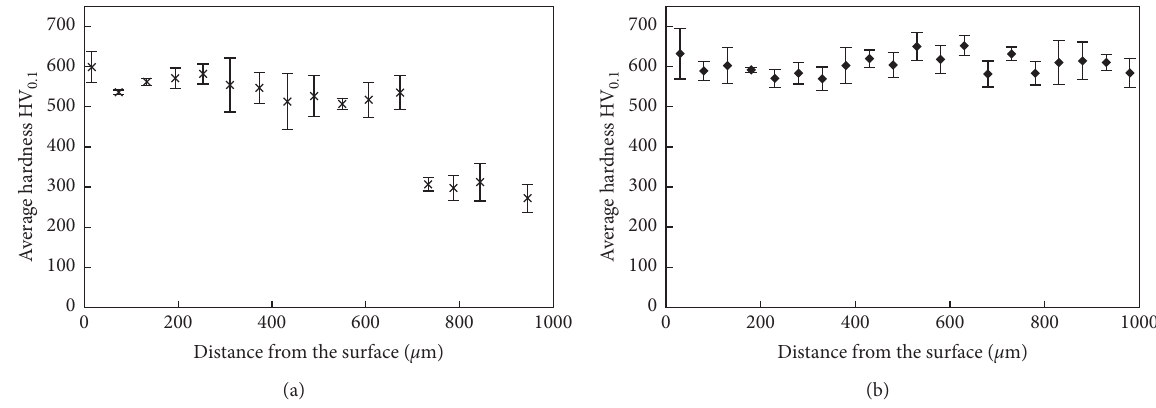
Figure 5: Microhardness profiles of the cross section of (a) LQ and (b) CQT